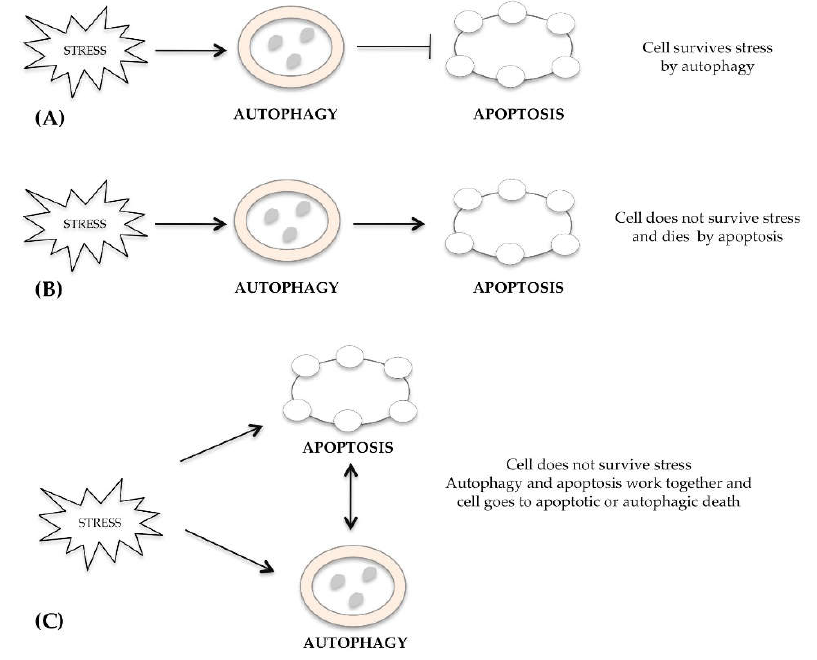
Figure 1. Cross-talk between autophagy and apoptosis. ( A ) After stress signal, cells survive by activating the autophagic pathway, which blocks death by apoptosis; ( B ) Alternatively, the autophagic mechanism fails and cells dies by apoptosis; ( C ) Damage activates both autophagy and apoptosis, which work together; cell does not survive, but dies.